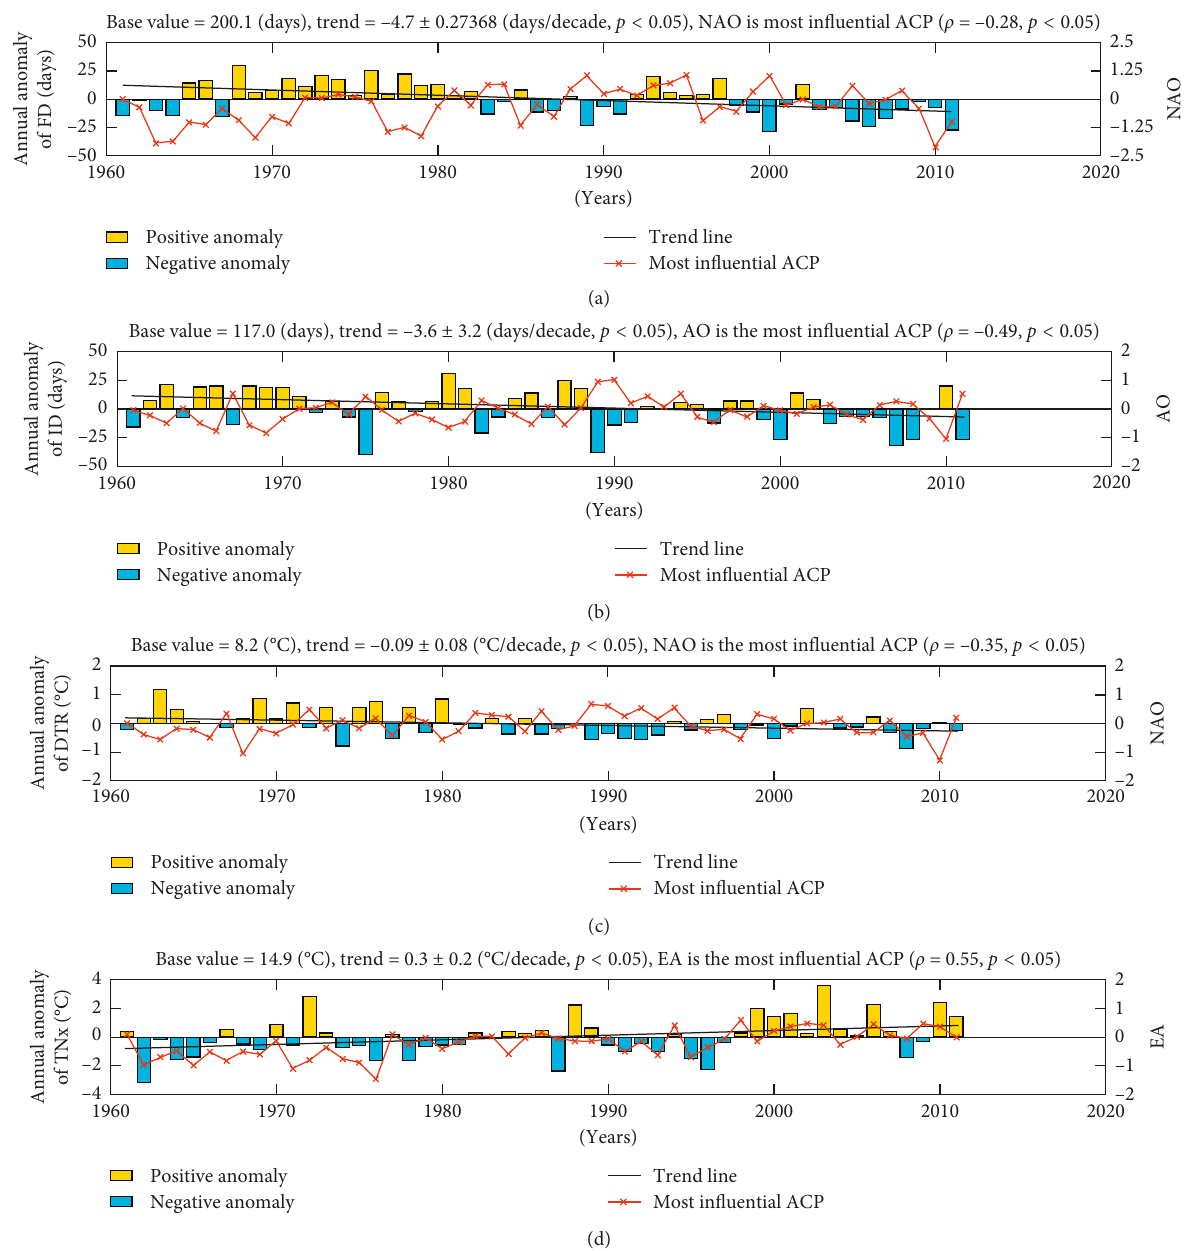
Figure 3: Time series with trend line and most influential NHTP for (a) FD, (b) ID, (c) DTR, and (d) TNx, on the country scale in Finland during